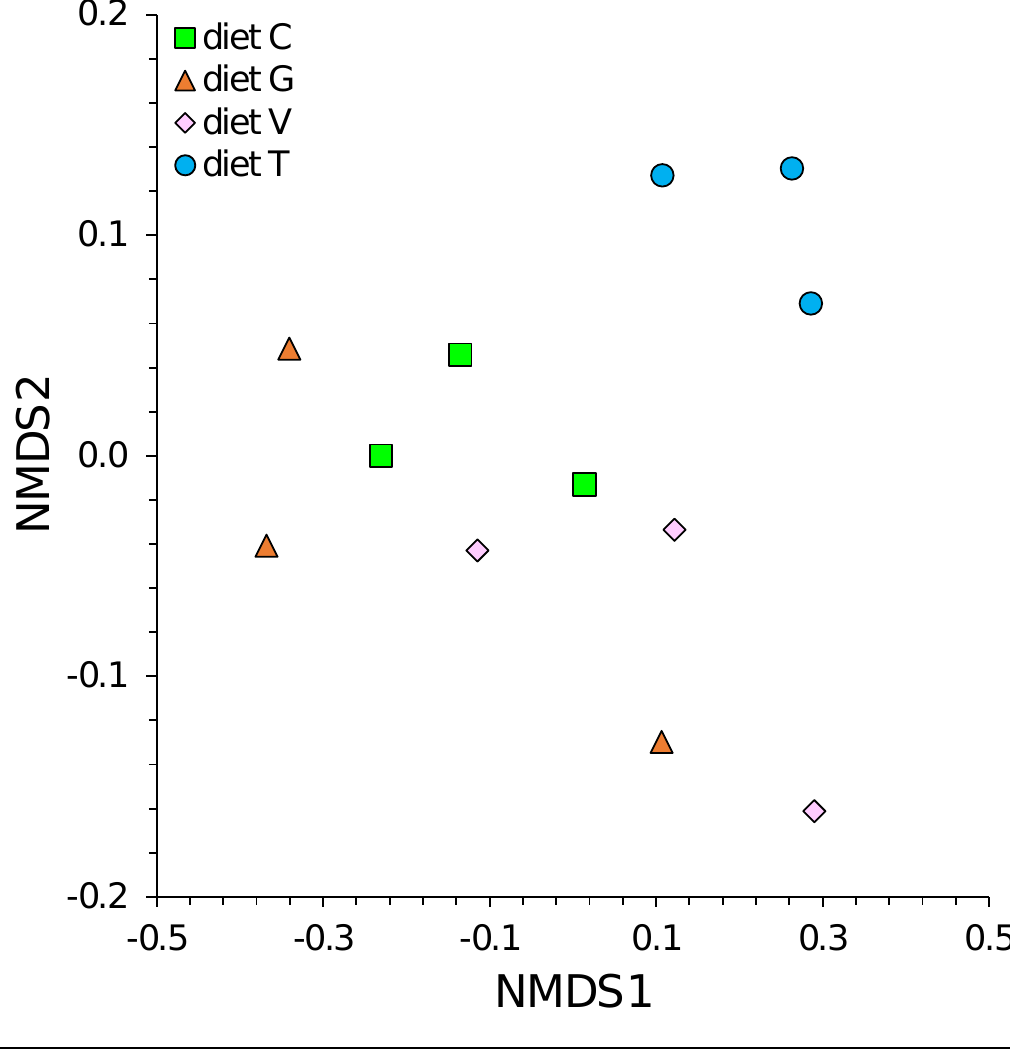
Figure 2. Non-metric multidimensional scaling (NMDS) based on Hellinger transformed genus relative abundance data.